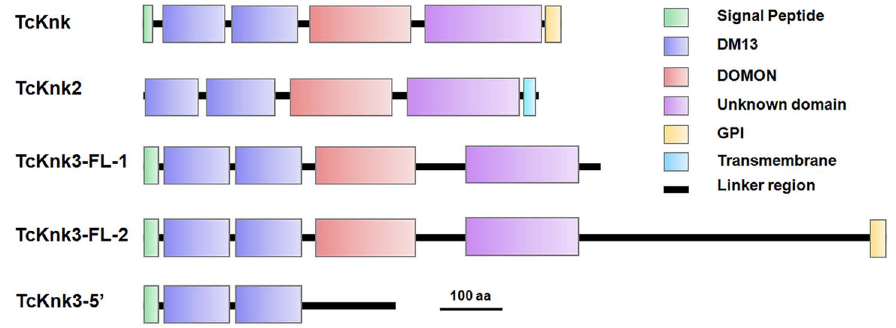
Figure 4. Domain architecture of putative TcKnk-family proteins from Triboliumcastaneum . Domain analysis was done using SMART protein. Red: Signal peptide; Blue: DM13 domain; Purple: DM13 domain; Green: DOMON domain; Yellow: GPI anchor; Cyan Blue: Trans-membrane domain.